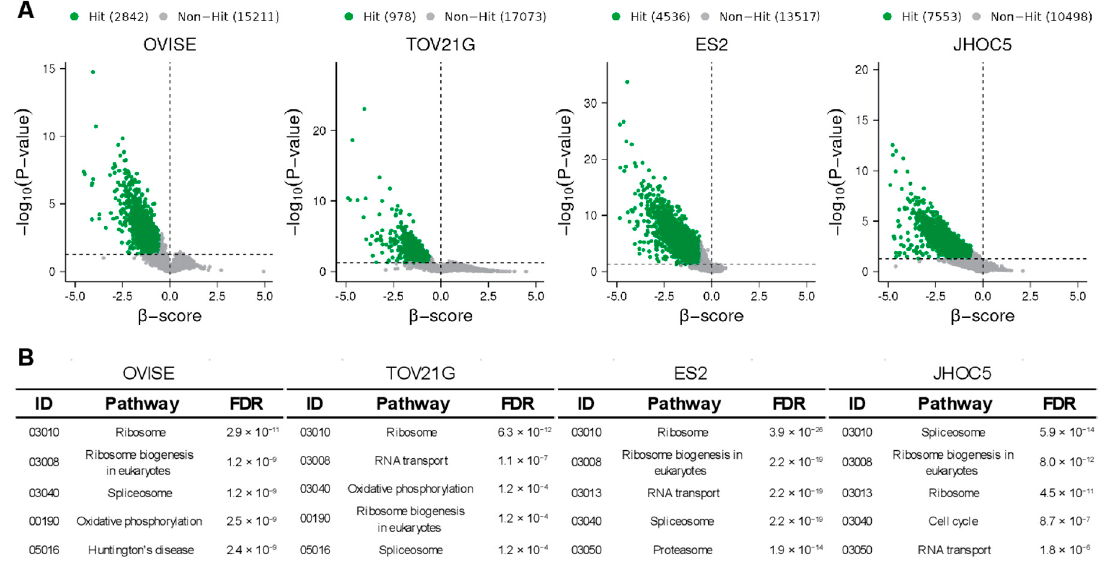
Figure 1. Genome-wide CRISPR/Cas9 screens using OCCC cell lines. ( A ) CRISPR-Cas9 screening results analyzed by MAGeCK-MLE. Green points represent significantly depleted genes (beta ≤ − 0.6, p -value ≤ 0.05). Horizontal dotted lines represent p = 0.05. ( B ) Results of PATHWAY analysis of the top 1000 hit genes in ( A ) using STRING-db. The top 5 pathways are shown along with their associated false discovery rates